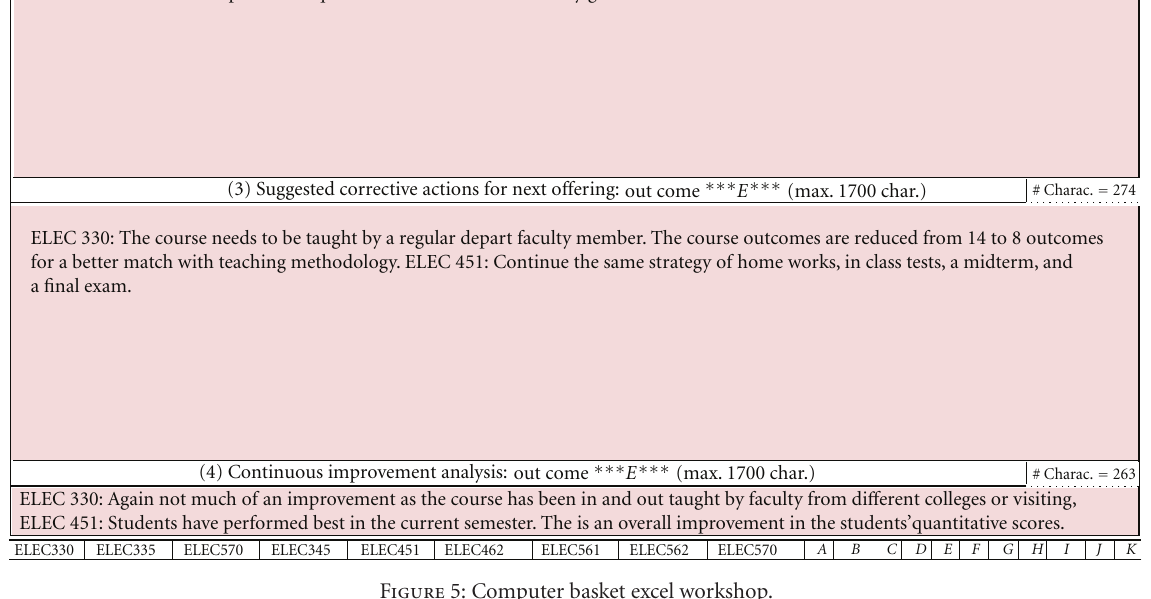
Figure 5: Computer basket excel